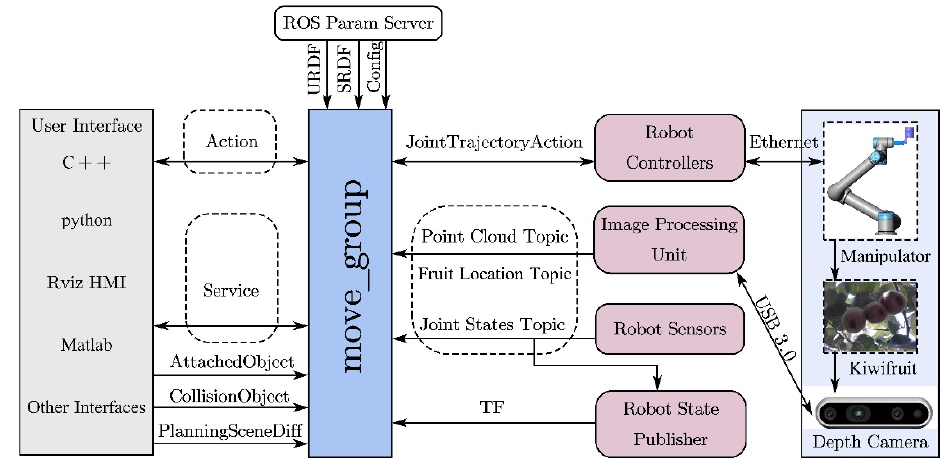
Figure 12. Schematic diagram of harvesting-robot control system based on